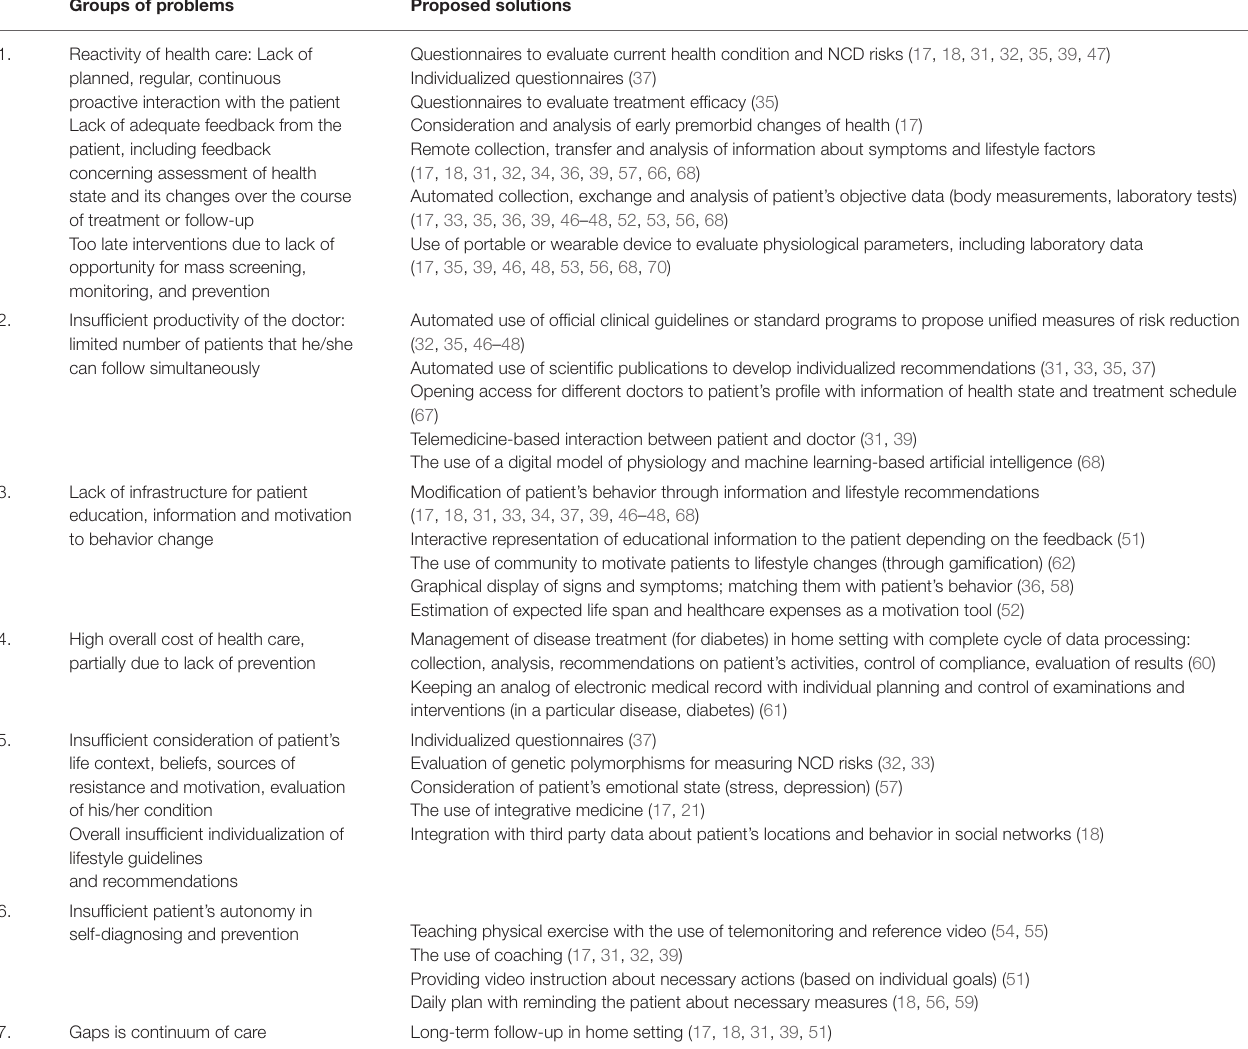
TABLE 2 | Problems that a system of personal health management should address and certain common technical solutions for them found in automated health management systems (AHMS) proposed in patent literature. Groups of